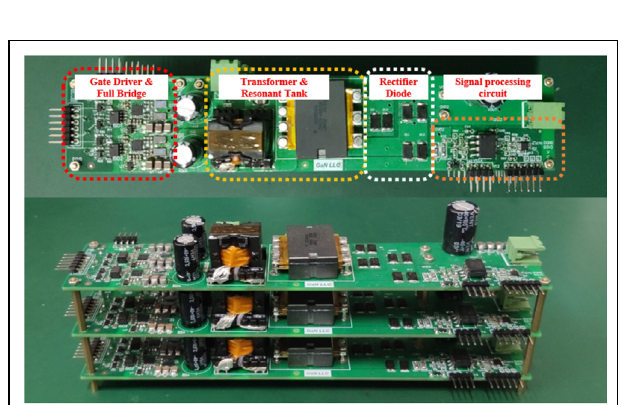
FIGURE 9 | The proposed current ripple and efficiency optimal control method.